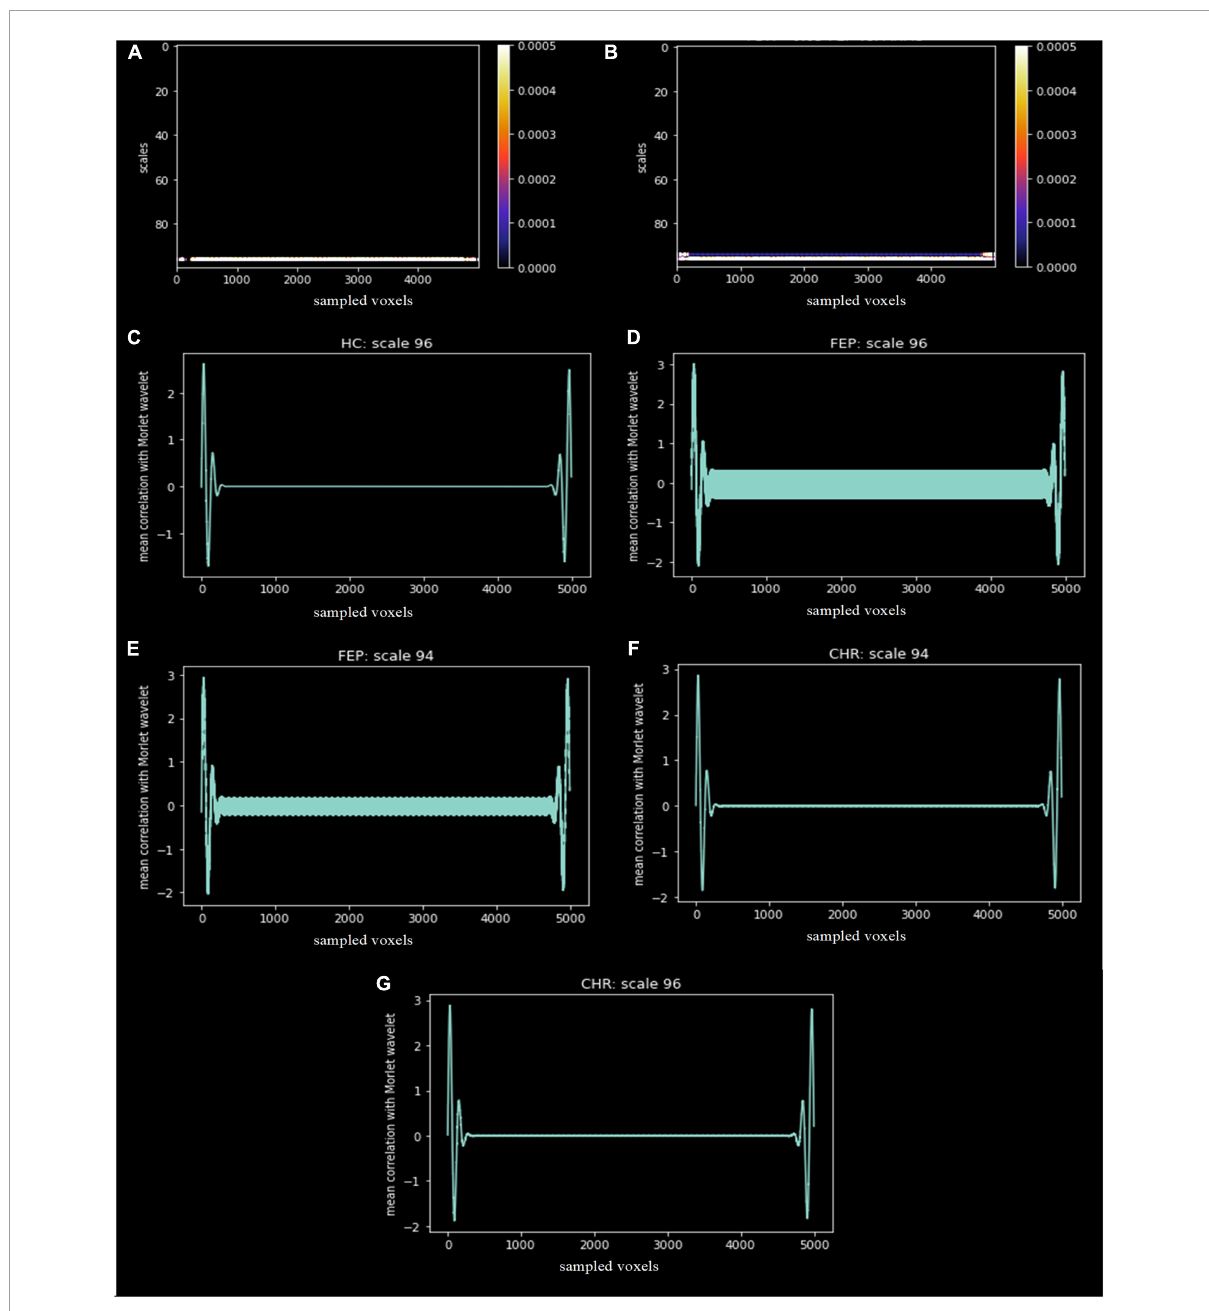
FIGURE7 Statistically significant differences, corrected with FDR < 0.05, between groups (A) FEP vs. HC and (B) FEP vs. CHR. The x-axis represents the sampled voxels, the y-axis represents the scales and the colors represent the value of the corrected p-values. The colorbar shows the range of the corrected p -values in this graph. The mean correlation of the Morlet wavelet with the lambda values of HC (C) , FEP and CHR subjects for scale 96 (D,G) and 94 (E,F) are